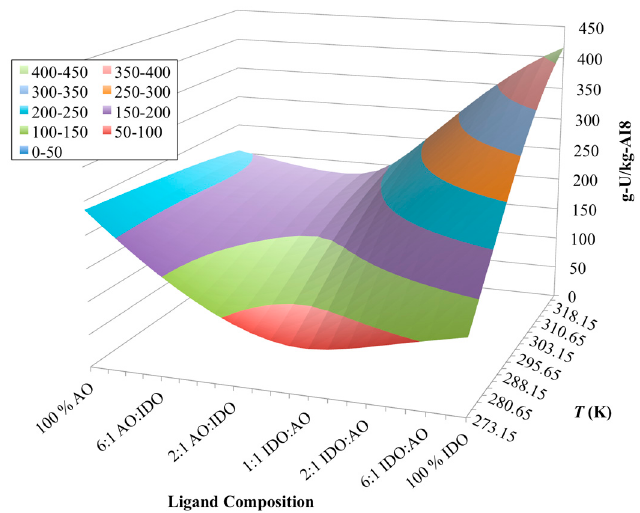
Figure 8. Simulation results of the chemisorption model for various ligand compositions on the AI8 material. Chemisorption of uranium appears to change from slightly exothermic to endothermic as the ligand composition changes from 100% AO to 100%